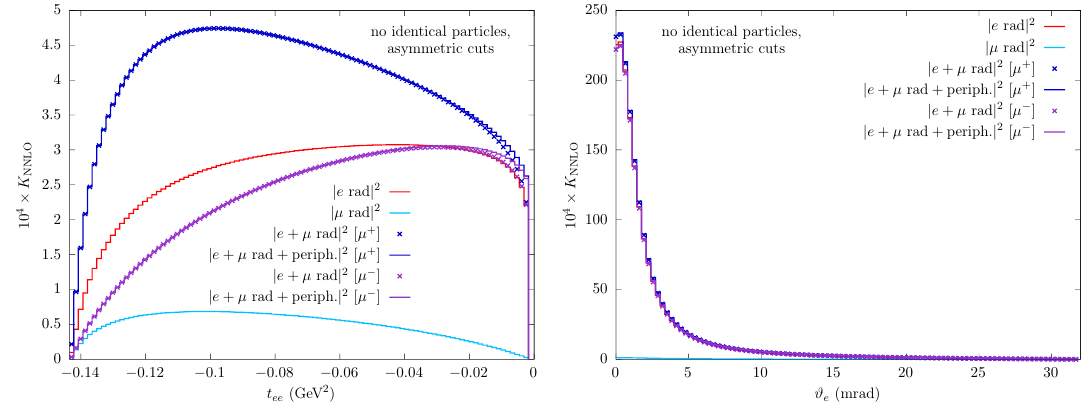
Figure 16. Real e + e − radiation effects with academic event selection on t ee (left) and θ e (right) distribution.